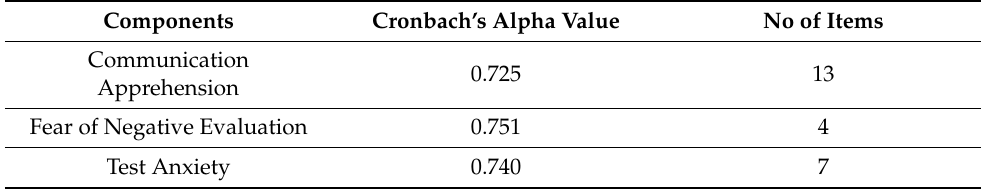
Table 1. Cronbach’s Alpha for Student’s Speaking Performance Components.